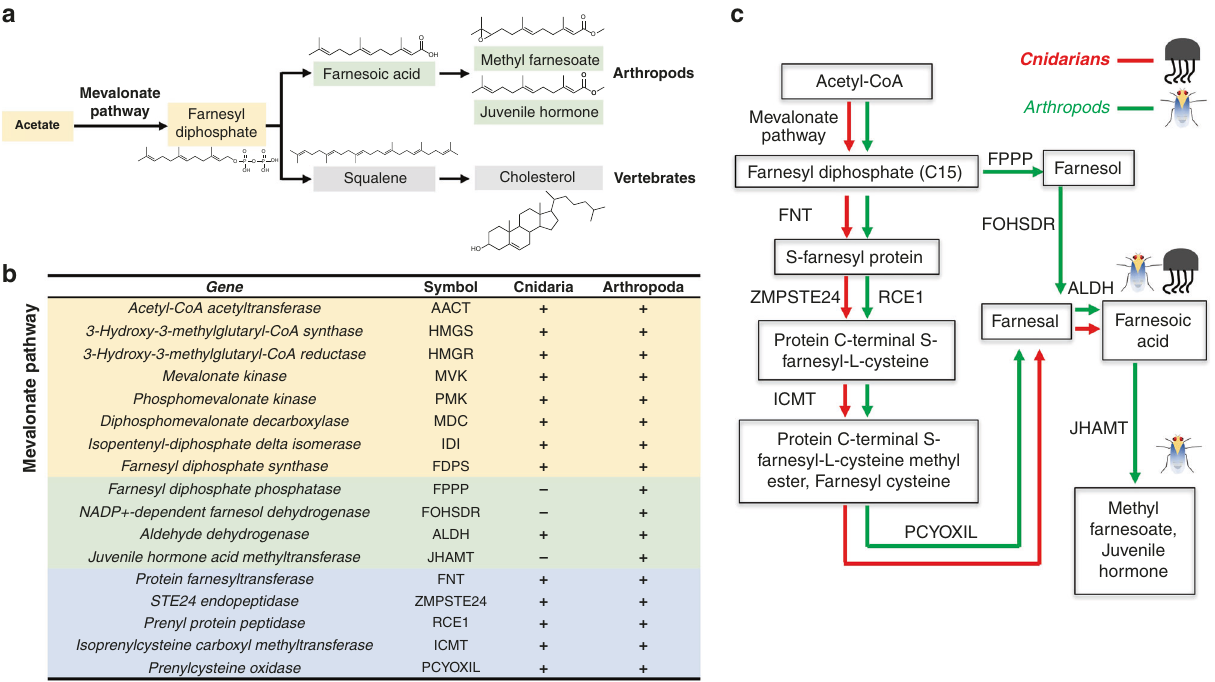
Fig. 4 Sesquiterpenoids in cnidarians. a Comparison of terpenoid and cholesterol biosynthesis in arthropods and vertebrates; b Comparison of gene homologues involved in the terpenoid backbone biosynthetic pathway and the hormone biosynthetic pathway in Cnidaria and Arthropoda, plus and minus denote the presence and absence of that gene in respective phyla; c Schematic diagram summarising terpenoid backbone biosynthesis and hormone production in Cnidaria and